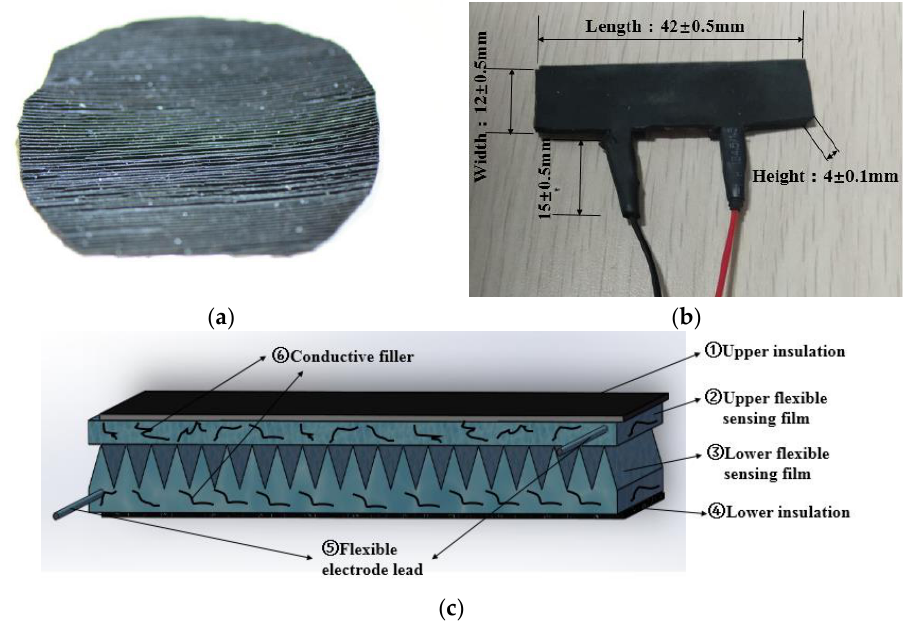
Figure 1. Polymer-based piezo-resistive flexible sensor. ( a ) Micro-structured film. ( b ) Sensor. ( c ) Theoretical diagram.